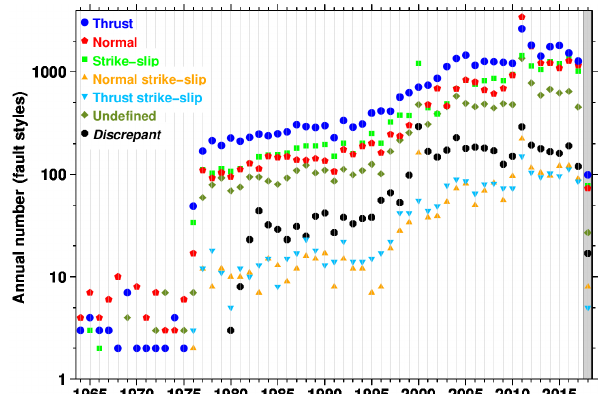
Figure 6. Annual number of source mechanisms grouped by Zoback (1992) fault styles. Dark blue circles, red pentagons, green squares, orange triangles, light blue inverted triangles, and olive di- amonds represent, respectively, thrust, normal, strike–slip, normal with strike–slip component, thrust with strike–slip component, and undefined earthquakes. Black octagons are earthquakes for which the intra-variability of the source mechanisms does not allow us to assign an earthquake to a fault style. These are earthquakes with large rotation angles (see Fig. 5). The percentage of such earth- quakes goes up to 8% of earthquakes per year. The grey area for year 2018 denotes that the data collection is not yet complete. See main text for